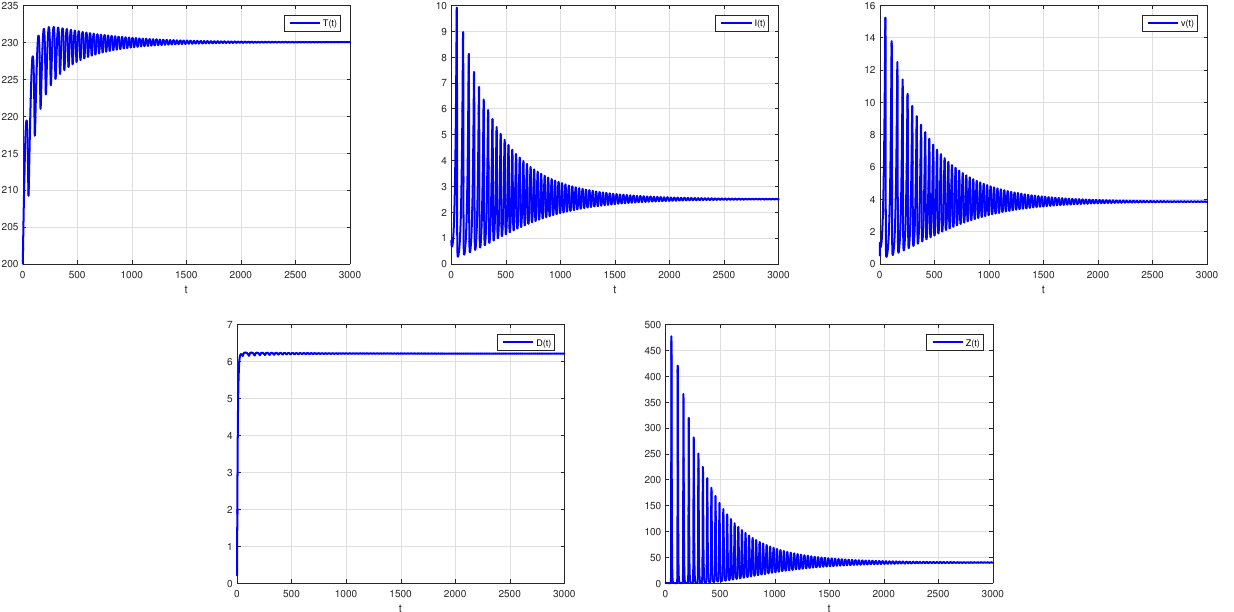
Figure 4. The solution curves of model (2). Here, the immunity-activated equilibrium E ∗ ≈ ( 230.0089421,2.5,3.846153846,6.215633383,39.60627404 ) is globally asymptotically